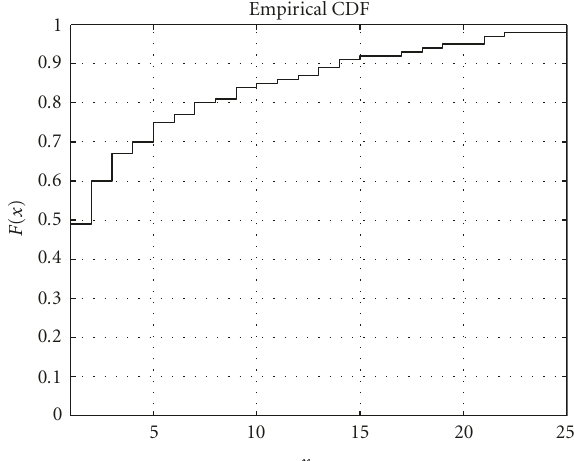
Figure 7: The empirical cumulative distribution function (cdf) of the number of pruning iterations for finding the minimum schedule in terms of timeslots.